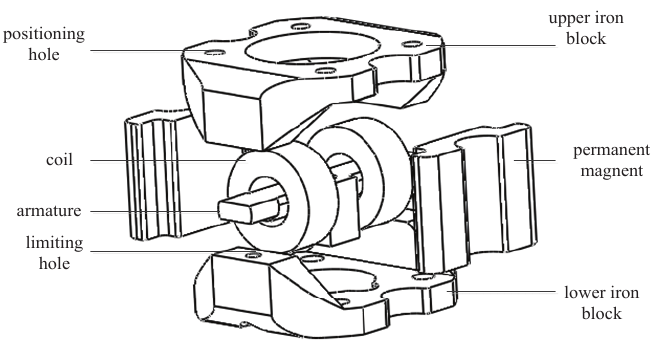
Figure 1. Schematic drawing of the packaged hydraulic torque motor.